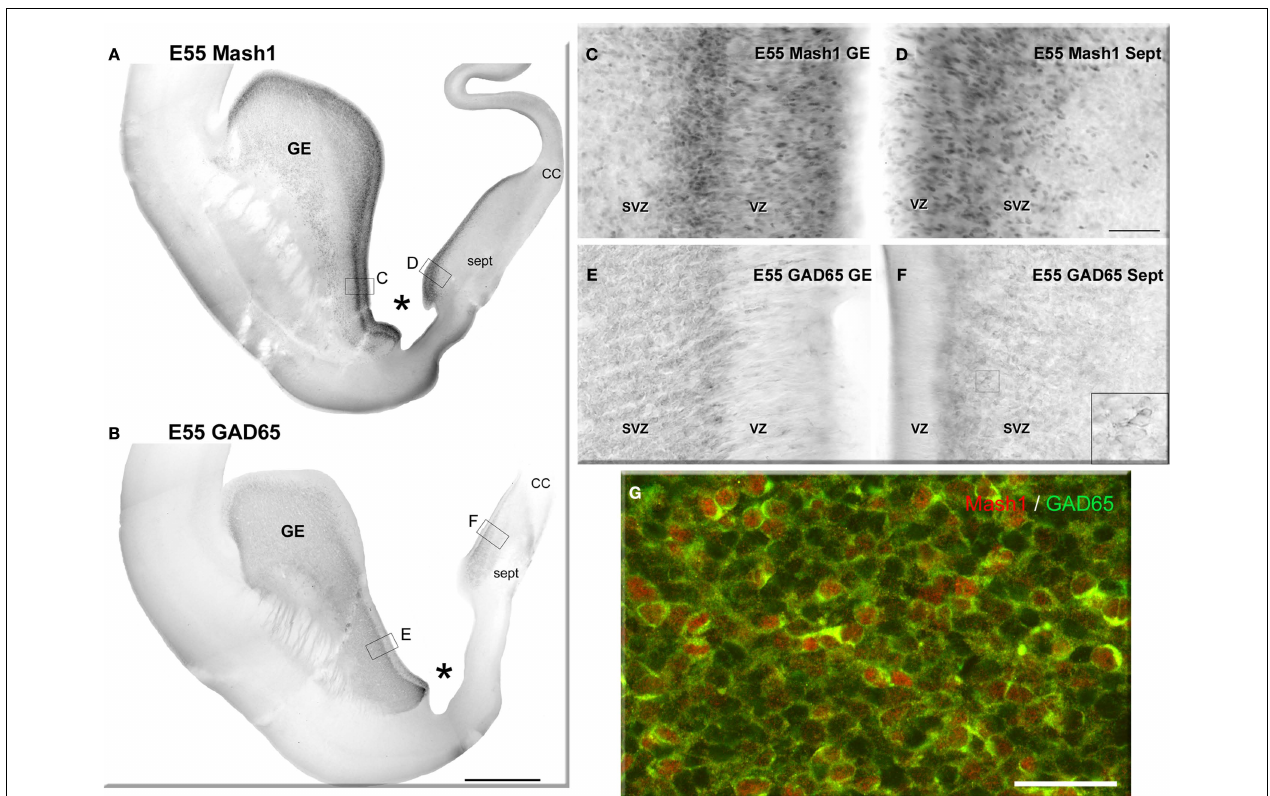
FIGURE 2 | Neurogenesis of GABAergic neurons in the ventral telencephalon of a monkey fetus at embryonic day (E) 55. (A,B) Adjacent sections labeled for Mash1 (A) and GAD65 (B) from a E55 fetal brain at a rostral level in which the lateral ventricle is dilated (paleocortical ventricle indicated by a star). (A) Progenitors labeled for Mash1 were present mainly in the ganglionic eminence (GE) [box magnifi ed in panel (C) ] and septal (Sept) proliferative zone [box magnifi ed in panel (D) ]. (B) GAD65-containing cells were observed in the same regions of the ventral telencephalon as Mash1, the GE and the Sept [boxes enlarged in panels (E) and (F) ]. (C–F) Figures correspond to magnifi ed regions indicated by boxes in (A,B) . (C) In the GE many cells were labeled for Mash1 in the ventricular (VZ) and the subventricular zone (SVZ). The intensity of